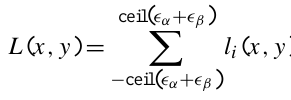
Table A1. Notation and